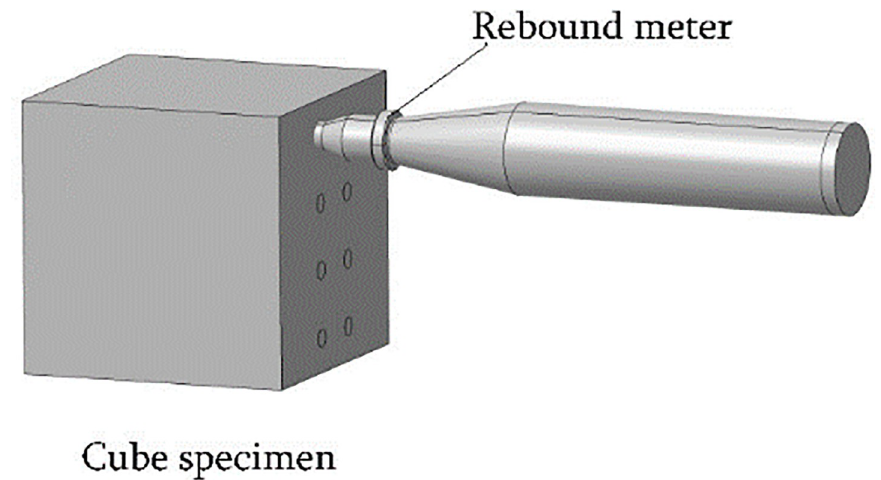
Fig 3. Schematic diagram of the rebound test.